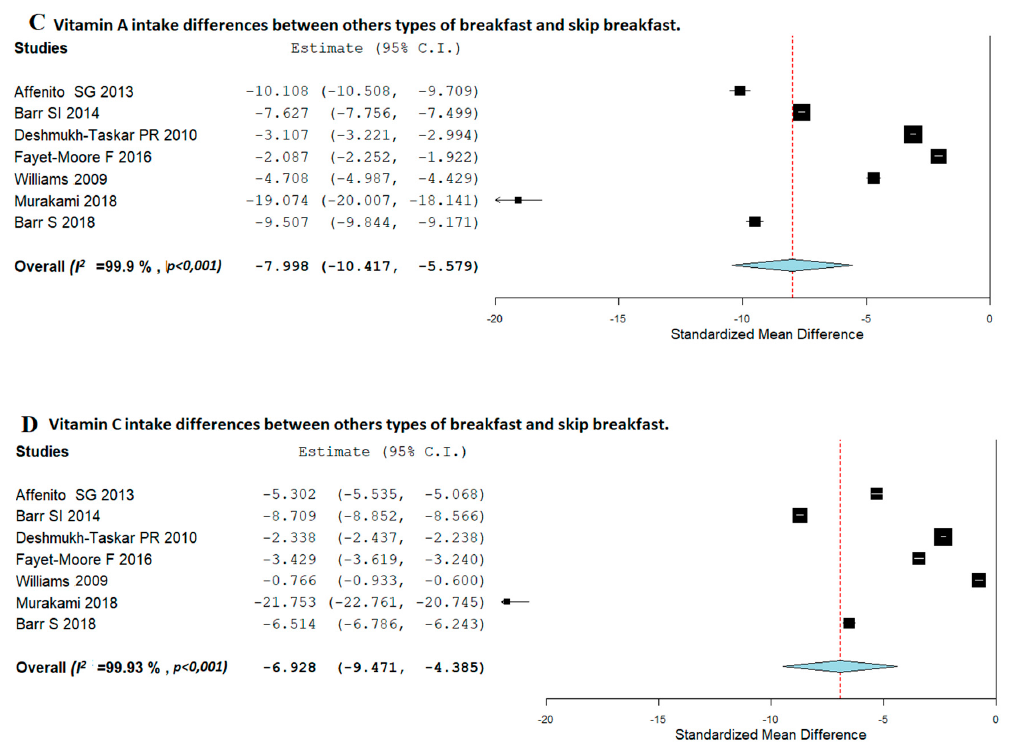
Figure 4. Random-effects meta-analysis of the effects of relationships between consumption of other types of breakfast and breakfast-skipping concerning vitamin B1 ( A ), vitamin B2 ( B ), vitamin A ( C ), and vitamin C ( D ) intake.